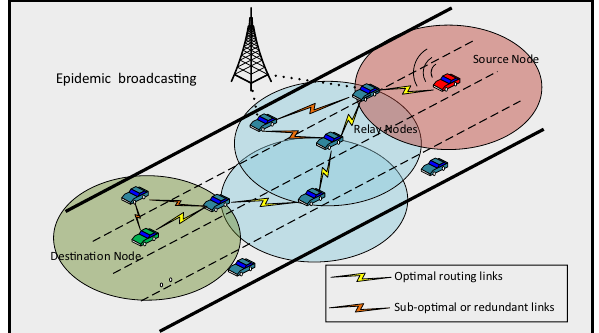
Figure 5 Epidemic-based message dissemination on the road